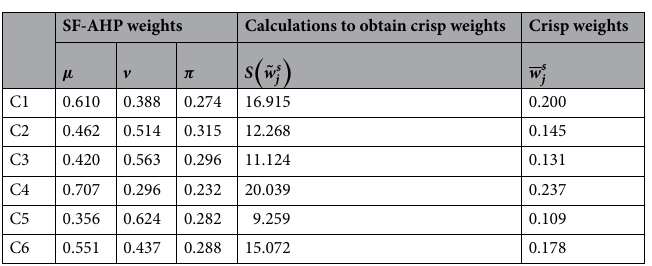
Table 10. The spherical weights from the SF-AHP